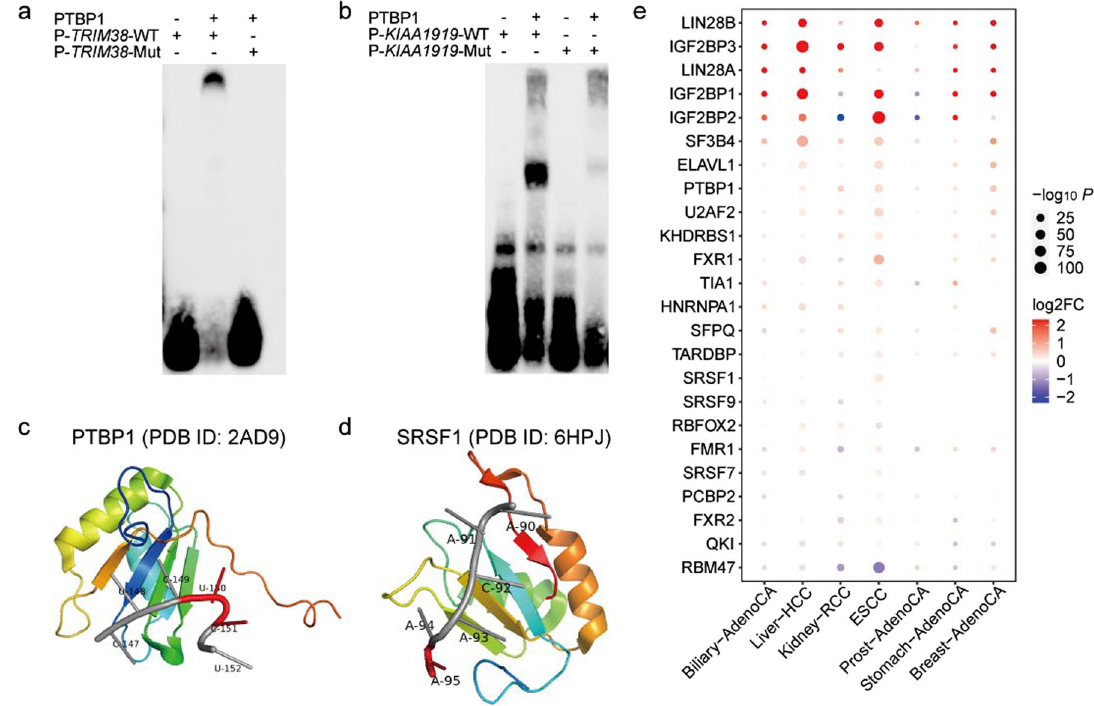
Fig. 3 The functional effects of 3 ′ -UTR piSNVs on RBP binding. Electrophoretic mobility shift assays (EMSA) results show the binding impact of 3 ’ -UTR piSNVs of TRIM38 ( a ) and KIAA1919 ( b ) on the recognition of PTBP1 to their RNA targets. Crystal structure of the PTBP1 ( c ; PDB ID: 2AD9) or SRSF1 ( d ; PDB ID: 6HPJ) in complex with speci fi c RNA motifs, red region on RNA oligo presented the mutated sites. e Expression of 24 enriched RBP motifs of 3 ′ -UTR piSNVs in different cancer